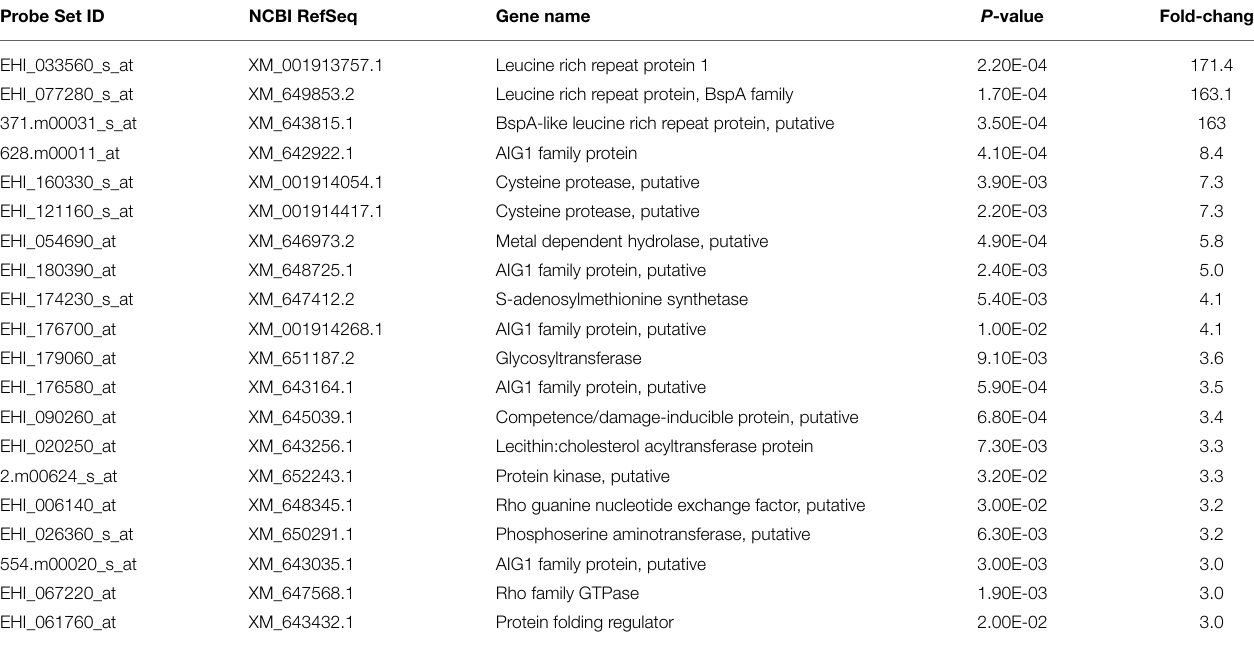
TABLE 3 | List of annotated genes that were downregulated in MTZR by > 3 fold. Probe Set ID